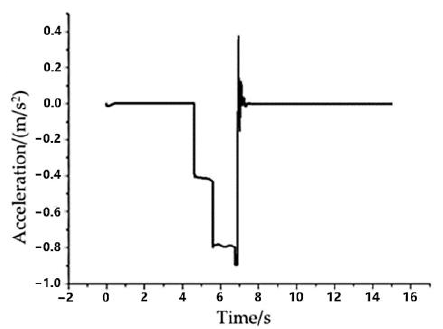
Figure 13. CCRb test acceleration change in the vehicle.